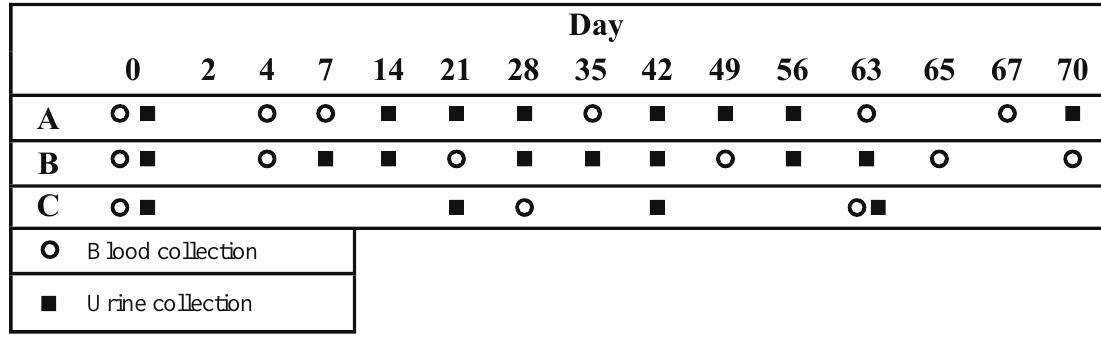
Figure 1. Blood and urine specimen collection schedules. Participants in groups PH